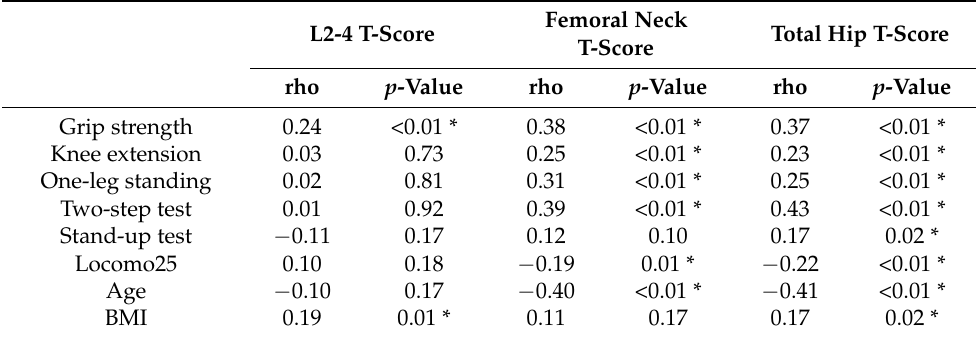
Table 4. Correlations between bone mineral density and physical performance.